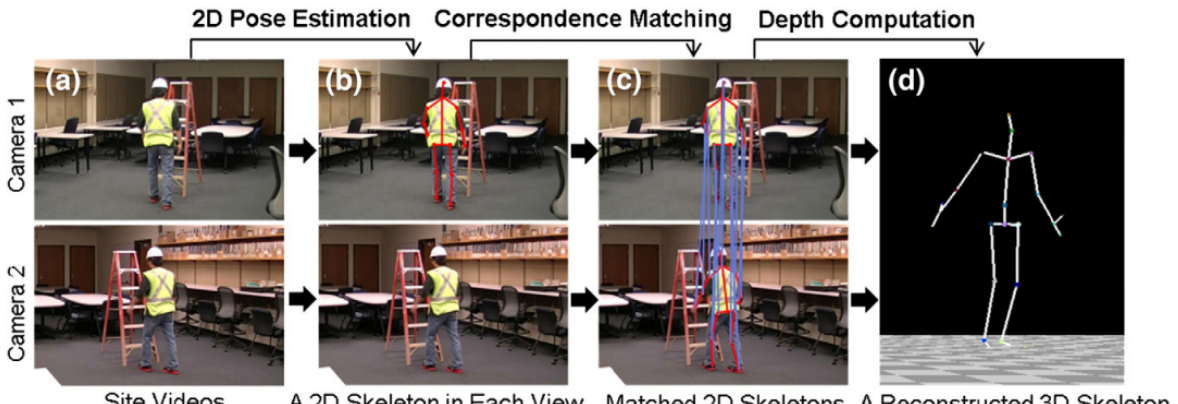
Figure 11. Skeleton capture process of 3D motion feature. ( a ) Two videos from a 3D camera or two separate cameras, ( b ) Estimate the position of body joints on 2D image sequences and 3D reconstruction. ( c ) Converting 2D body joints to 3D coordinates, ( d ) Getting a 3D skeleton model. Reproduced with permission from ref. [11]. Copyright 2013 Elsevier.